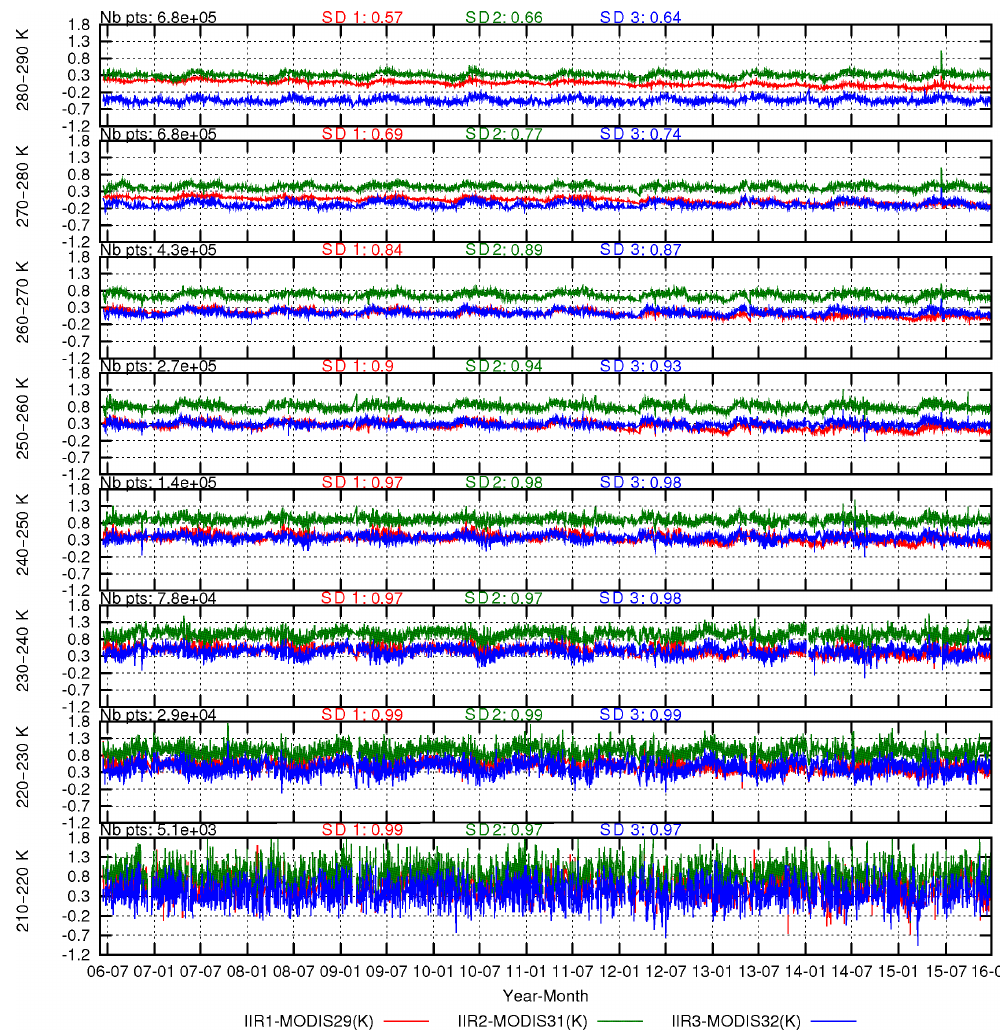
Figure 5. Same as Fig. 4 but at 30–60 ◦